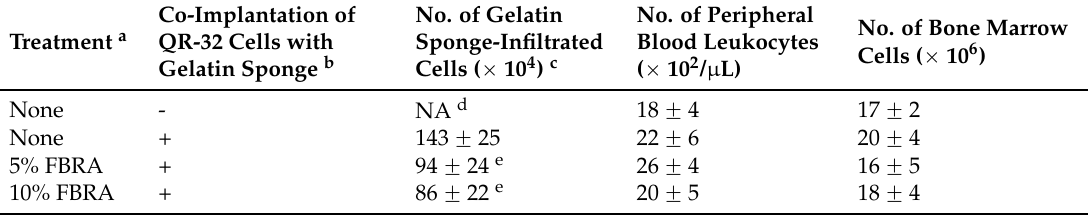
Table 3. Inhibition of infiltration of inflammatory cells into gelatin sponge by FBRA administration.